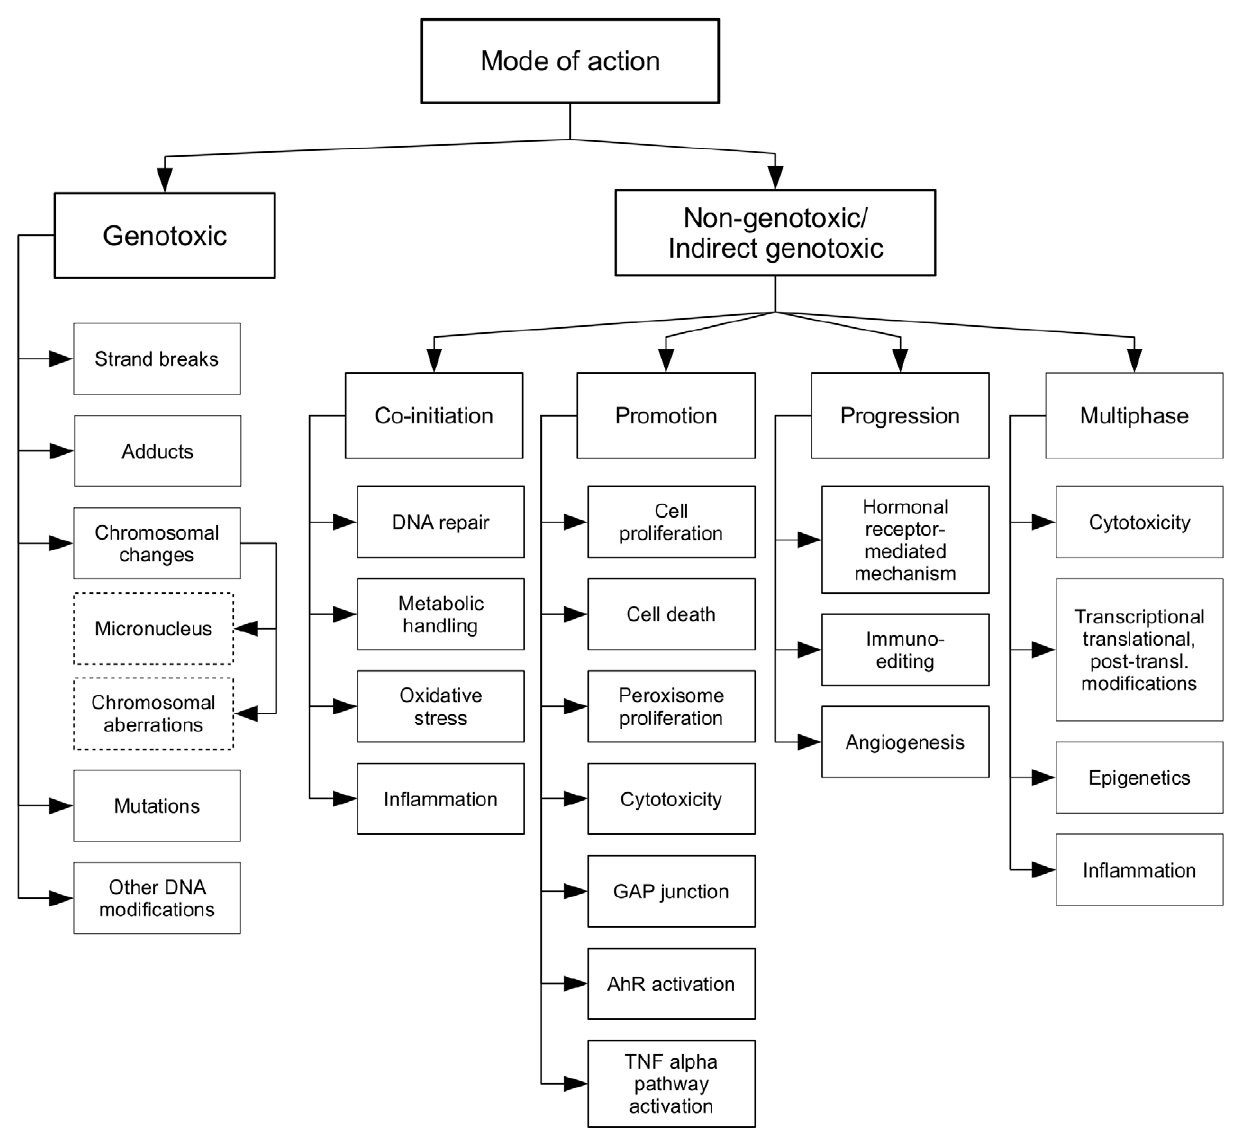
Figure 2. The ModeofAction taxonomy branch.